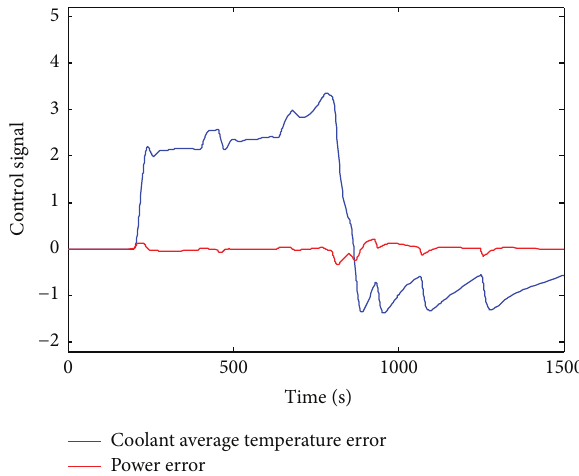
Figure 5: Comparison of two control signals under 5% FP/min ramp load decrease